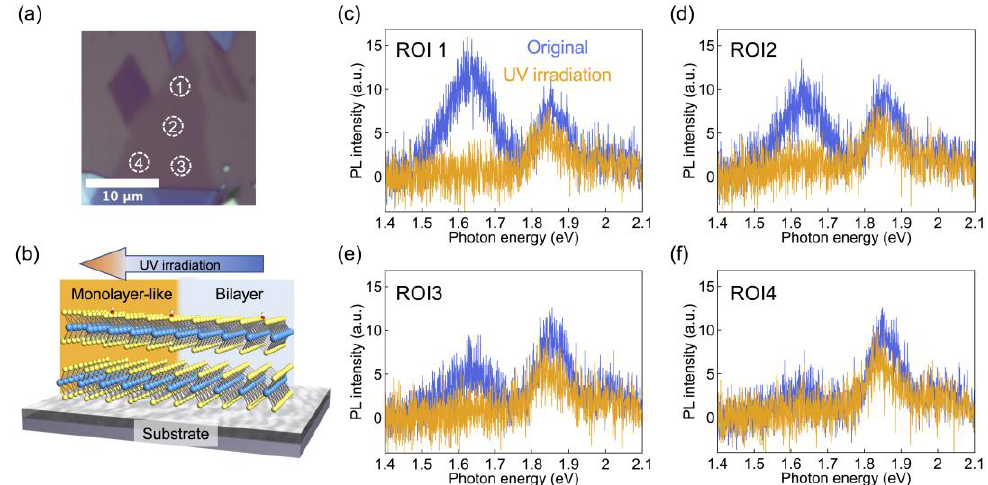
Figure 3. ( a ) Optical microscope image of the bilayer MoS 2 . The labels are the measurement regions (regions of interest (ROIs) 1–4) in Figure 3c–f. ( b ) Illustrative image of the modulation to the bilayer sample via the UV irradiation process. The process induces the bilayer to a monolayer-like state. ( c – f ) PL spectra for the as-exfoliated (original, blue) and the UV-irradiated (orange) samples in ( c ) ROI 1, ( d ) ROI 2, ( e ) ROI 3, and ( f ) ROI 4 in Figure 3a.